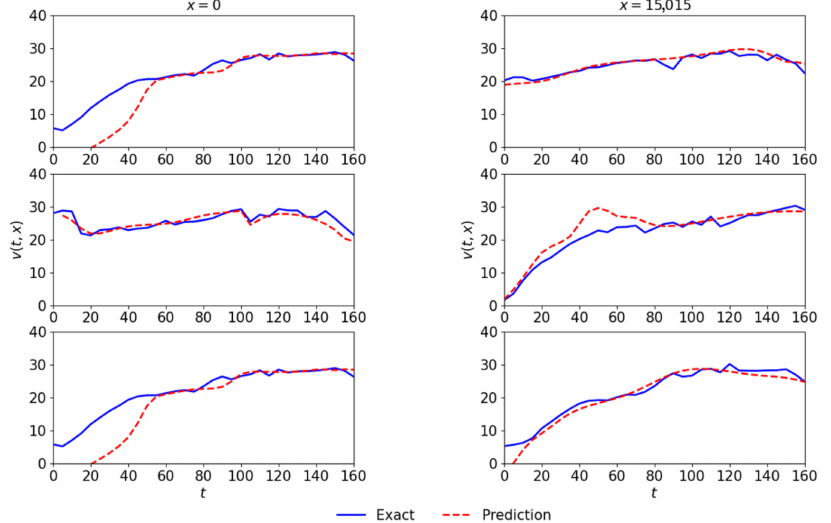
Figure 12. Actual and predicted speed at two intersections i.e., at x = 0 and x = 15,015 m, respectively given by the first and second columns. The first, second, and third rows respectively represent the network’s links L1, L2, and L3.